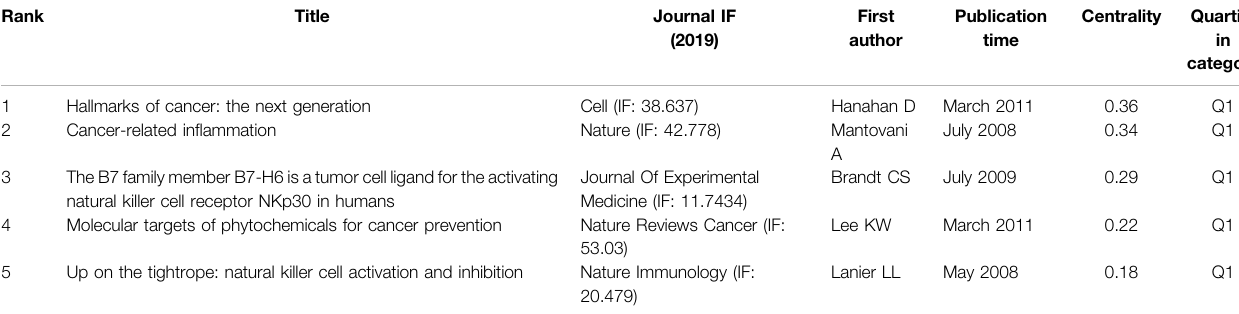
TABLE 7 | The top fi ve centrality of co-cited references related to natural products in cancer